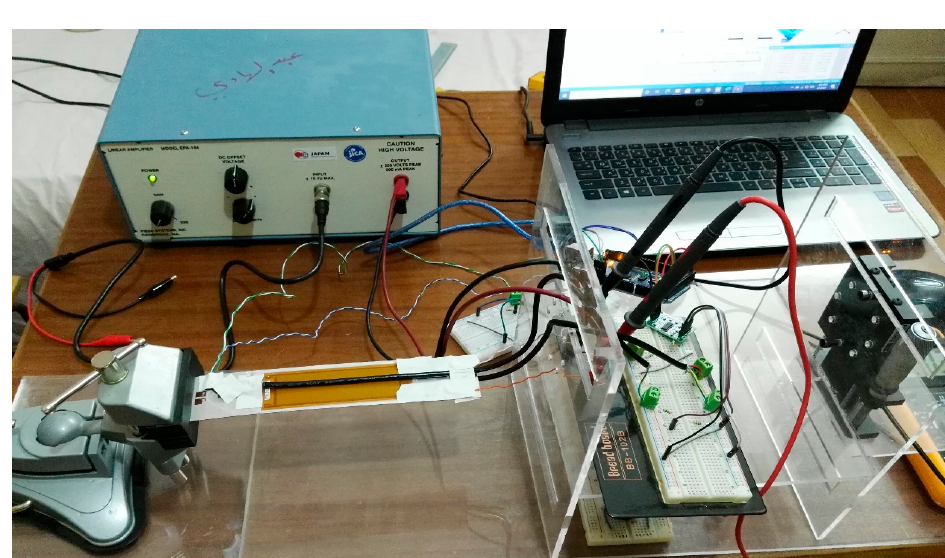
Figure 13. Prototype for the second verification.